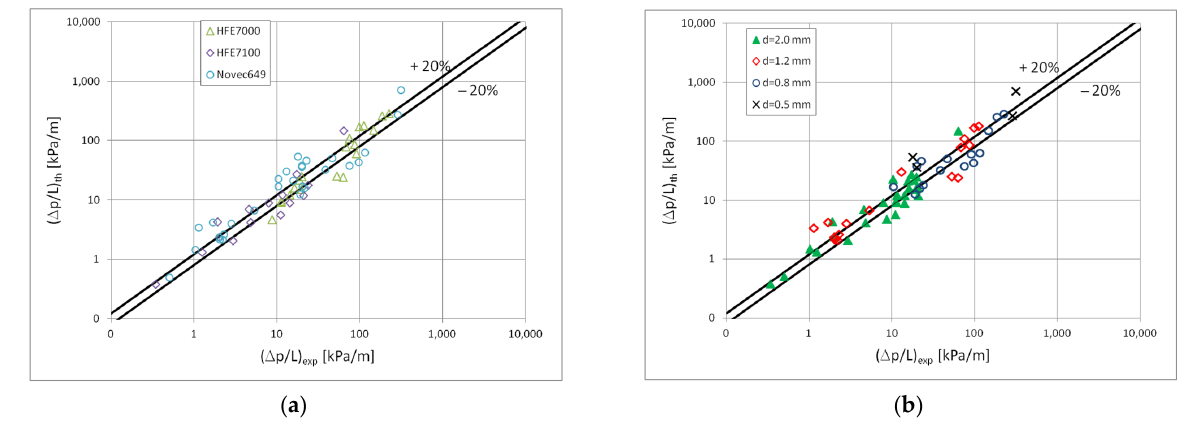
Figure 15. Comparison of the results of experimental studies of the investigated refrigerants con- densation in mini-channels in terms of pressure drops with the correlation (3) for the intermittent flow; ( a ) for individual factors, ( b ) for individual mini-channels diameters.